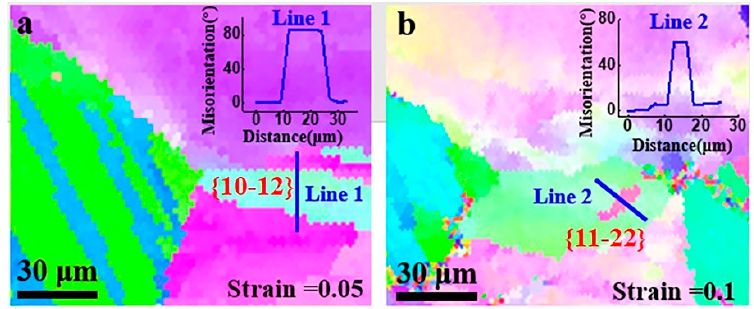
Figure 7. IPF and misorientation map with strains of ( a ): 0.05; ( b ): 0.10.